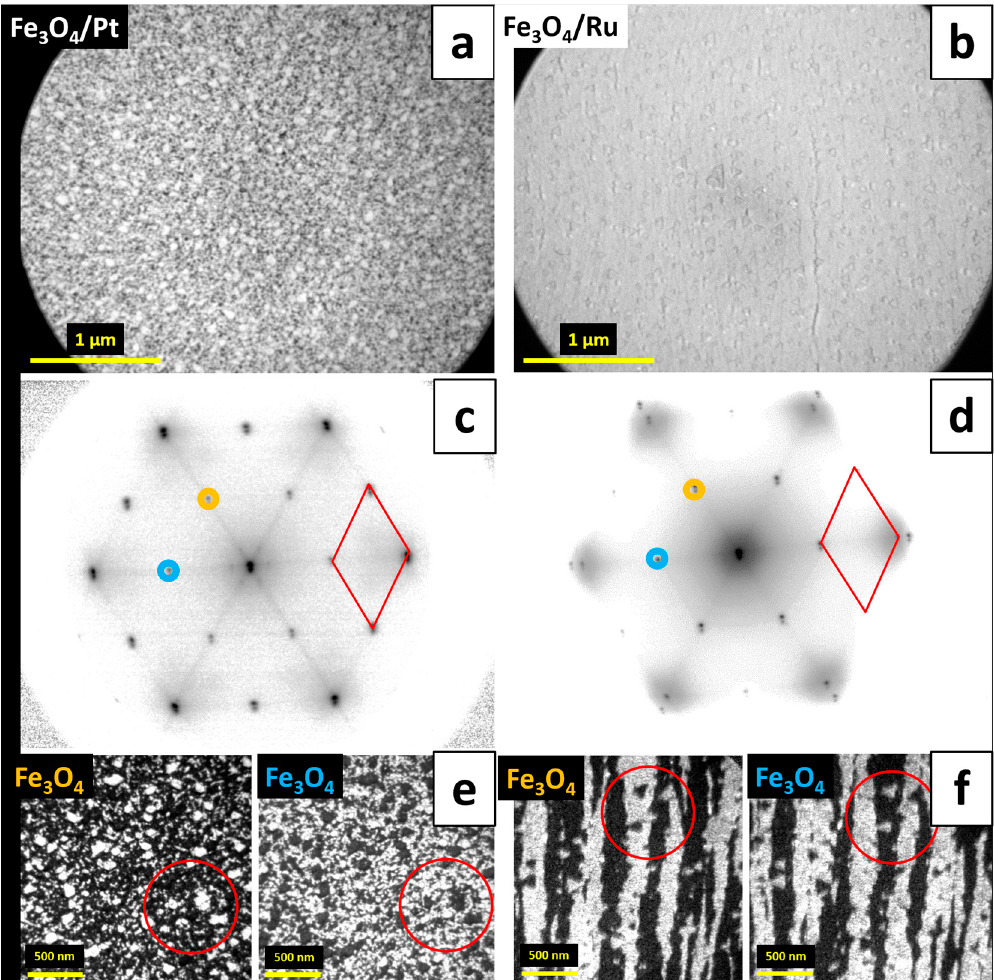
Figure 6. LEEM images (energy: 10 eV) ( a , b ) and µLEED patterns (energy: 42 eV) ( c , d ) of Fe 3 O 4 (111) films grown on Pt(111) ( a , c ) and Ru(0001) ( b , d ) by ~5.7 ML Fe deposition (total dose) under UHV at RT and post-oxidation in 1 × 10 − 6 mbar O 2 at 900 K; the Fe 3 O 4 (111) unit cell is marked on µLEED patterns with red rhombus; ( e , f ) present DF-LEEM images obtained by mapping the diffraction spots marked with colors in ( c ) and ( d ), respectively (red circles mark the same sample position on respective images) (imaging energies: 15 ( e ) and 20 eV ( f )).